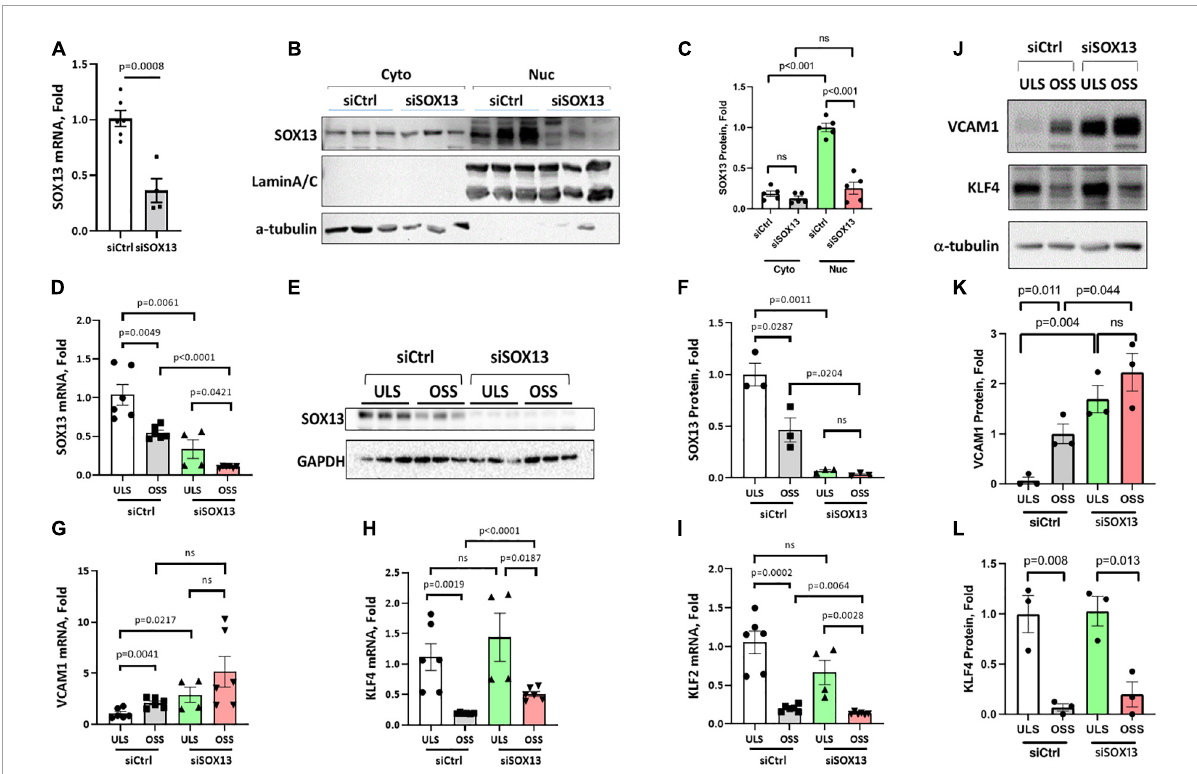
FIGURE3 siSOX13 knockdown of SOX13 in HAECs. (A–C) Static HAEC study. HAECs were treated with siSOX13 vs. siCtrl for 48 h, and analyzed by qPCR (A) and western blot using cytoplasmic and nuclear fractions with SOX13 antibody (B) and quantified (C) . (D–L) Shear study. HAECs treated with siSOX13 vs. siCtrl for 48 h were exposed to ULS or OSS for another 24 h, and analyzed for SOX13 by qPCR (D) , western blot of whole cell lysate (E,F) . Additional qPCR assays for VCAM1 , KLF4, and KLF2 (G–I) and western blots for VCAM1 and KLF4 (J,L) were conducted. Mean ± SEM, n = 4–6 (F,I) or 3 (K,L) are shown, and p -values calculated by student’s t